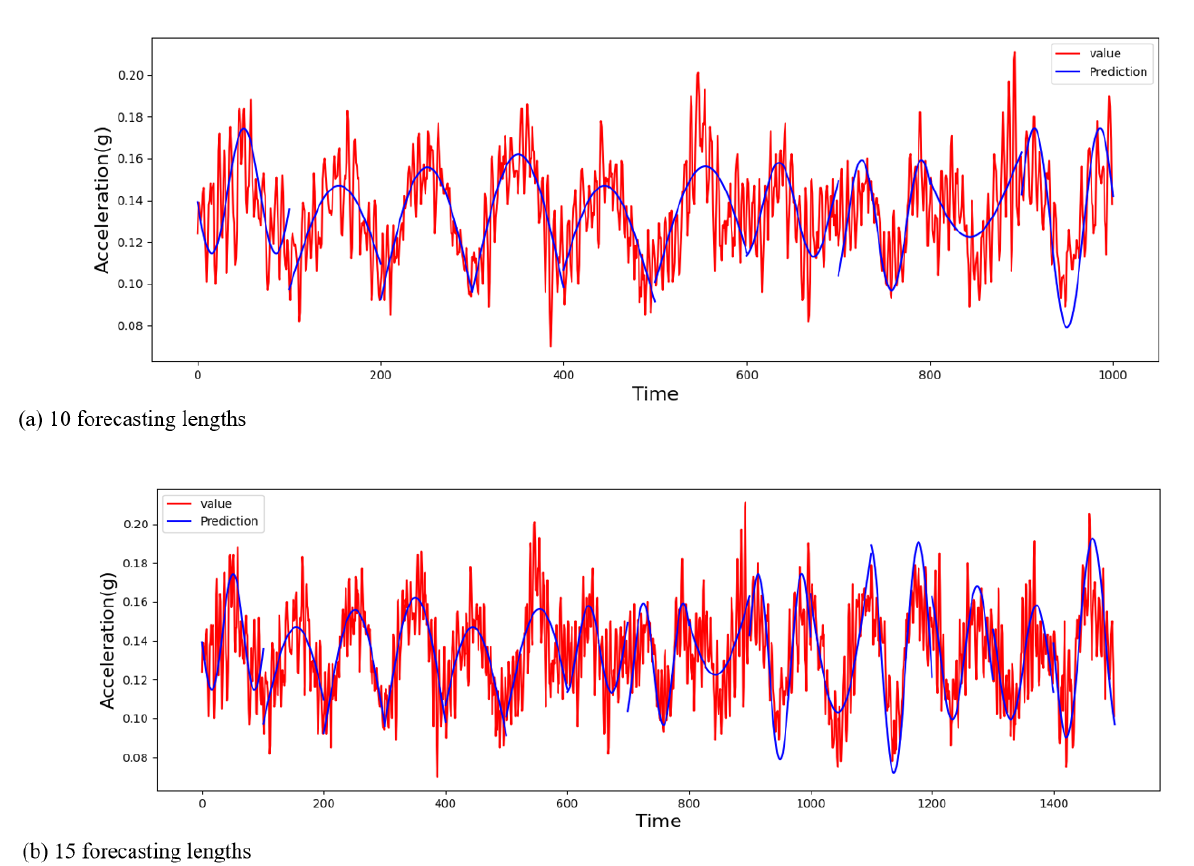
Figure 13. Structural state forecasting based on the FFT–Informer on 10 and 15 forecasting